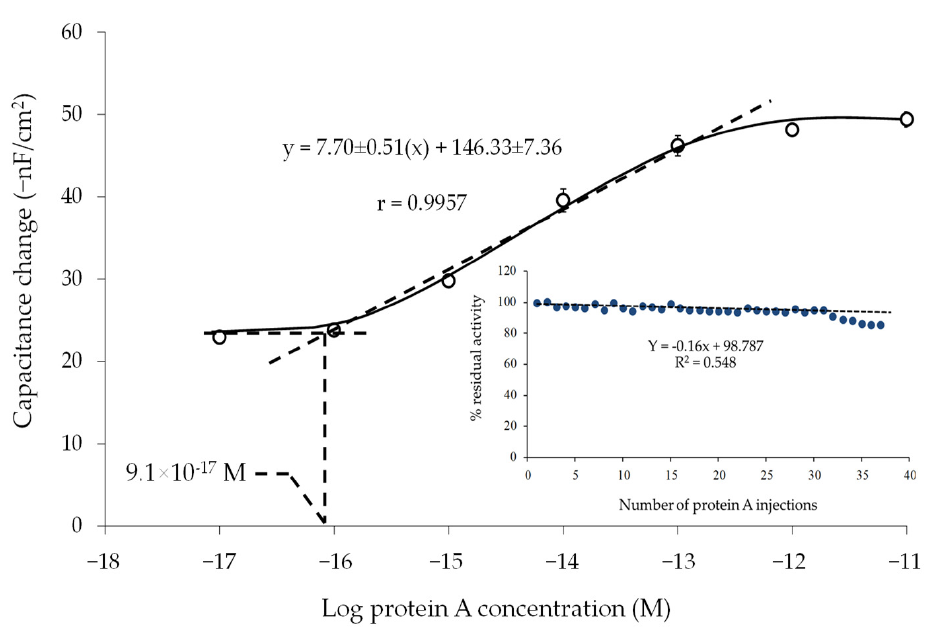
Figure 5. Capacitance change vs. logarithm of PA concentration; insert shows percentage residual activity of the electrode after regeneration.